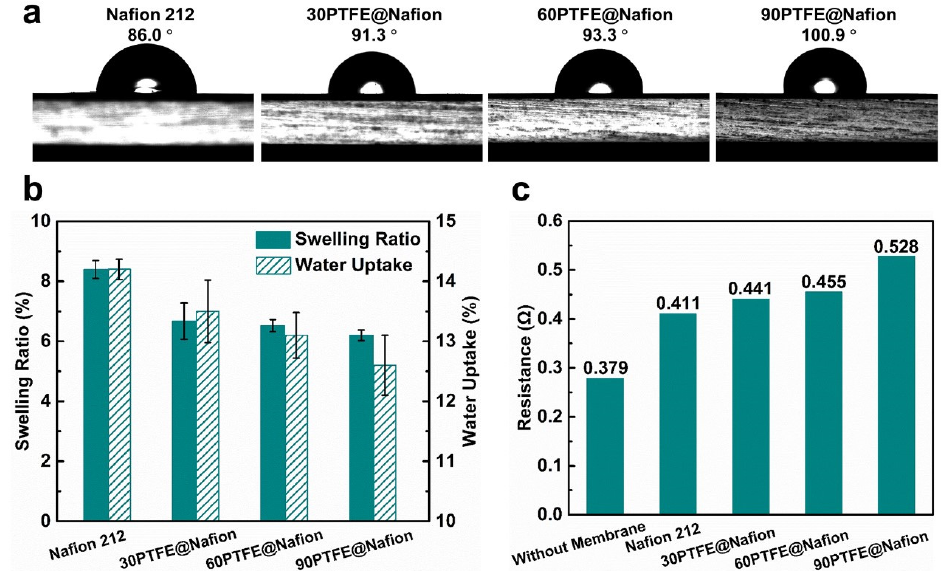
Figure 3. Surface wettability and dimensional stability of composite membranes. ( a ) Water contact angle, ( b ) swelling ratio and water uptake, and ( c ) membrane resistance.